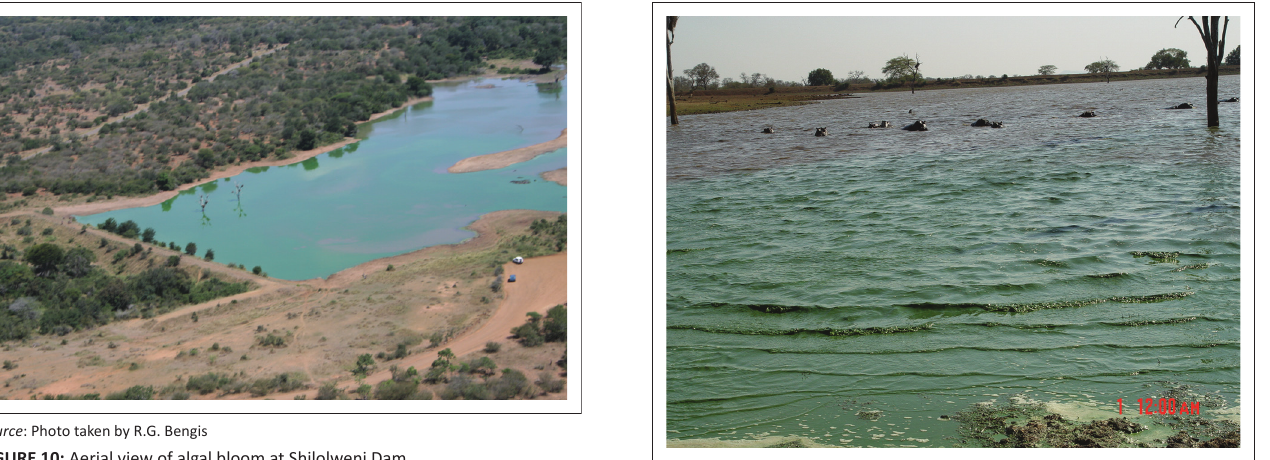
FIGURE 10: Aerial view of algal bloom at Shilolweni Dam.